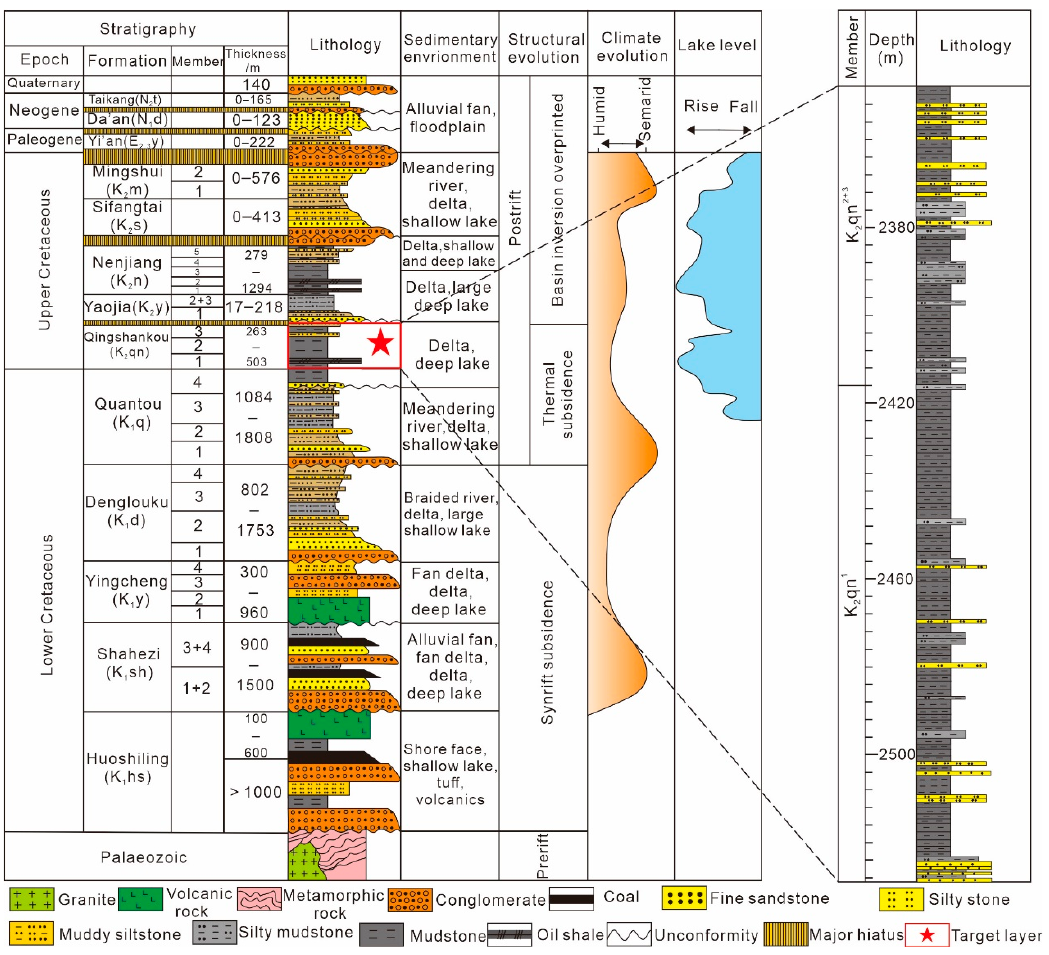
Figure 3. Stratigraphic column of the Cretaceous in the Songliao Basin showing sedimentary evolu ‐ tion (modified from Feng et al. [53]; Xu et al.